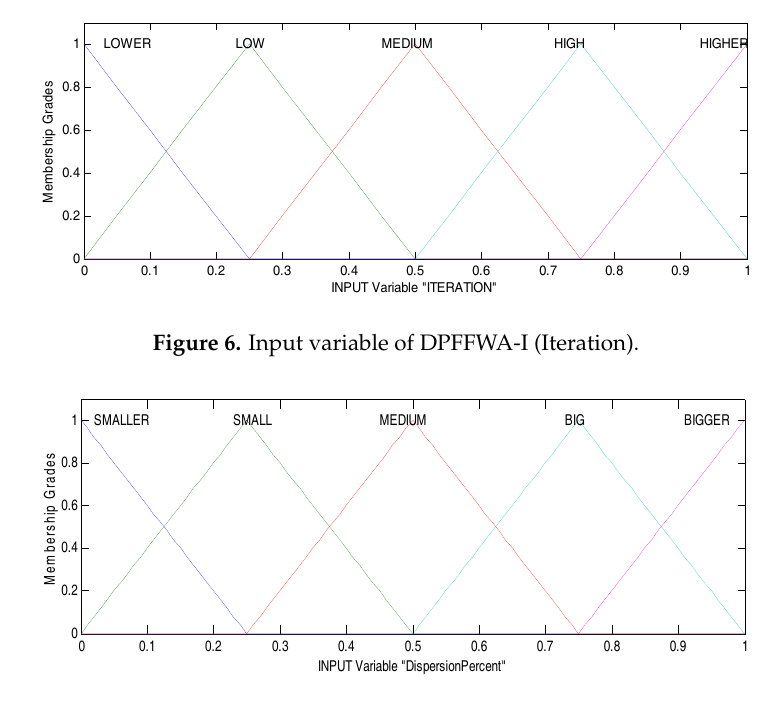
Figure 7. Input variable of DPFFWA-I (DispersionPercent).